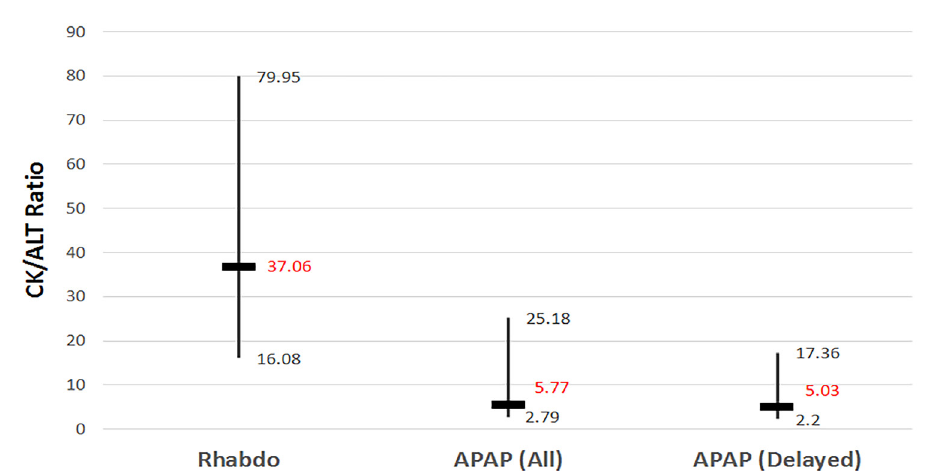
Figure 3. CK/ALT ratios of the three patient groups: rhabdomyolysis group; patients with acetaminophen overdose (all); and those with acetaminophen overdose (delayed). Rhabdo, rhabdomyolysis group; APAP (all) , all patients with acetaminophen overdose; APAP (delayed) , patients with delayed acetaminophen toxicity. Vertical bars indicate interquartile range of values; horizontal bars indicate median